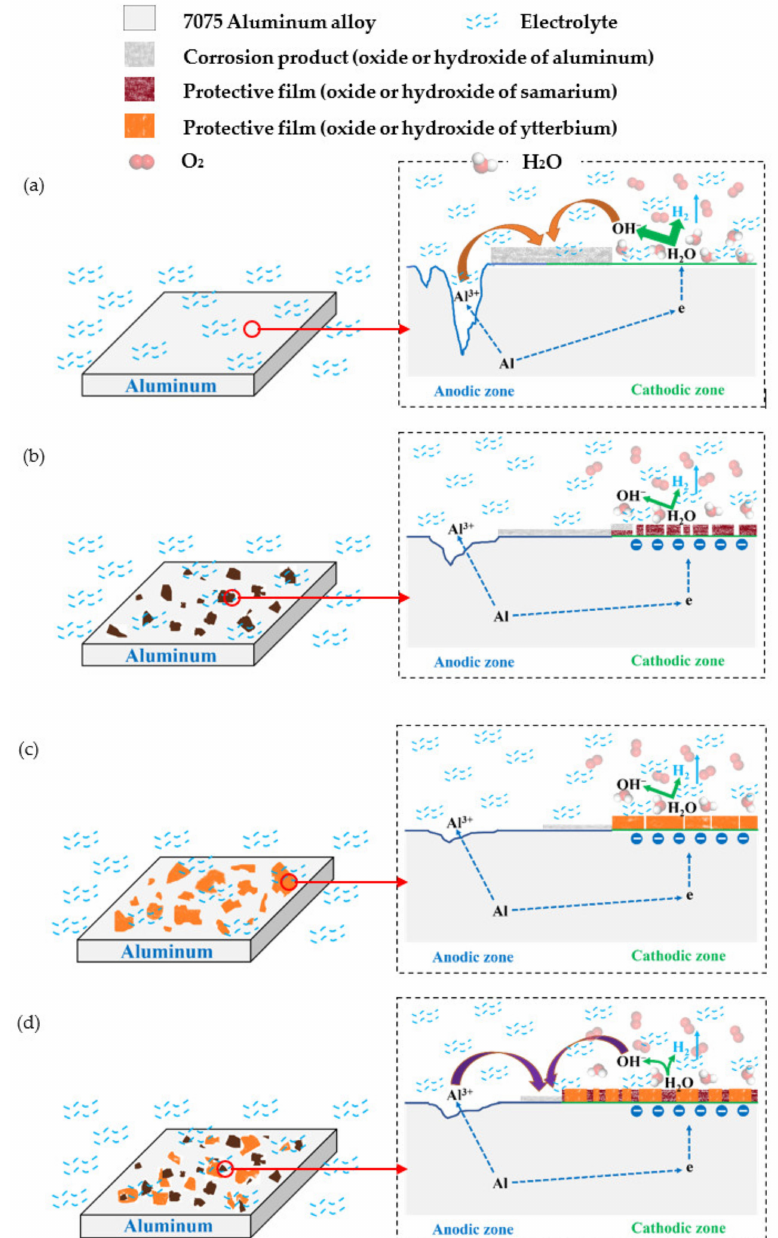
Figure 8. Hypothetical model of the influence mechanism of different additives on 7075 Al corro- sion behavior and discharge performance: ( a ) blank; ( b ) Sm(OAc) 3 ; ( c ) Yb(OAc) 3 ; ( d ) Sm(OAc) 3 + Yb(OAc) 3